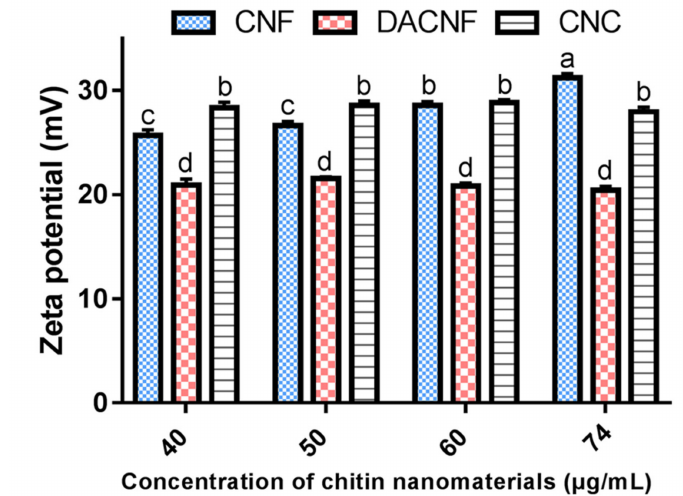
Figure 5. Zeta potentials of di ff erent concentrations of chitin nanofibers (CNF), deacetylated chitin nanofibers (DACNF), and chitin nanocrystals (CNC). a–d Value for each sample with di ff erent superscripts are significantly di ff erent ( p < 0.05).